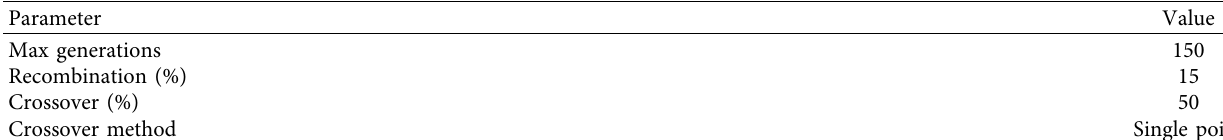
Table 6: Genetic algorithm parameters.